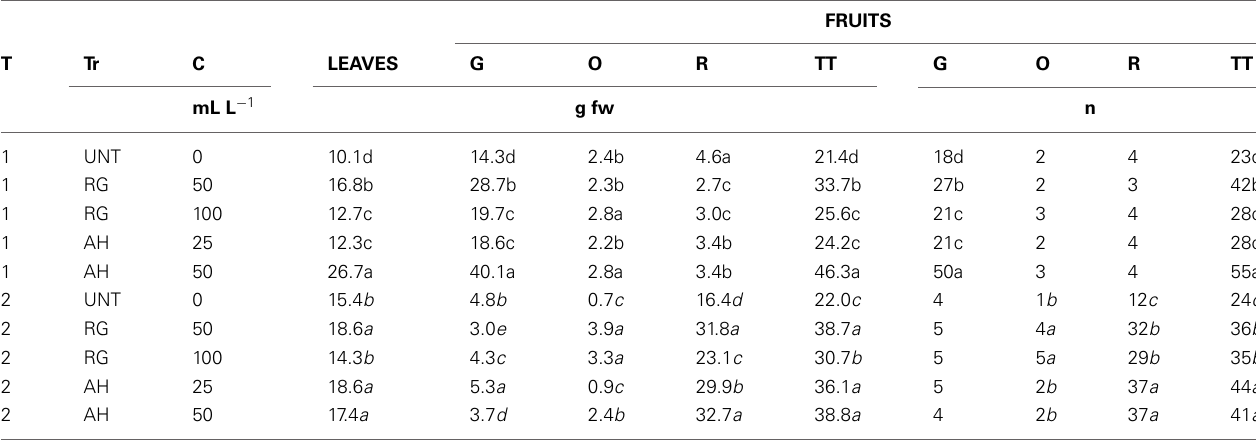
Table 2 | Fresh weights and number of leaves and fruits (g fw, n) after the 1st and 2nd (T1 and 2) application of biostimulants (untreated, UNT; red grape, RG; alfalfa hydrolyzed,